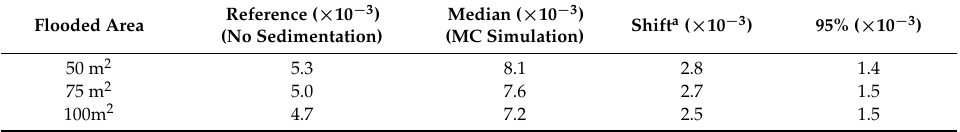
Table 3. Summary statistics of probability of infection per year for adults in the ‘Tuindorp’ catchment. Flooded Area